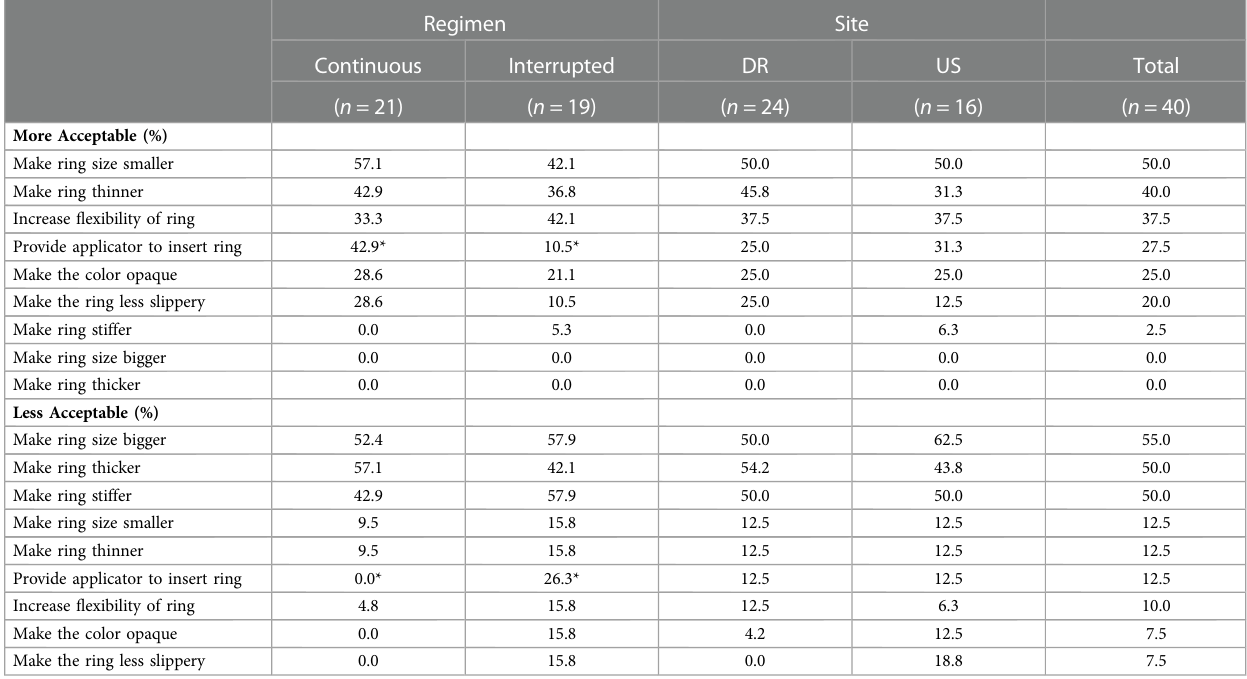
TABLE 3 Acceptability of potential changes to ring characteristics by regimen and site at